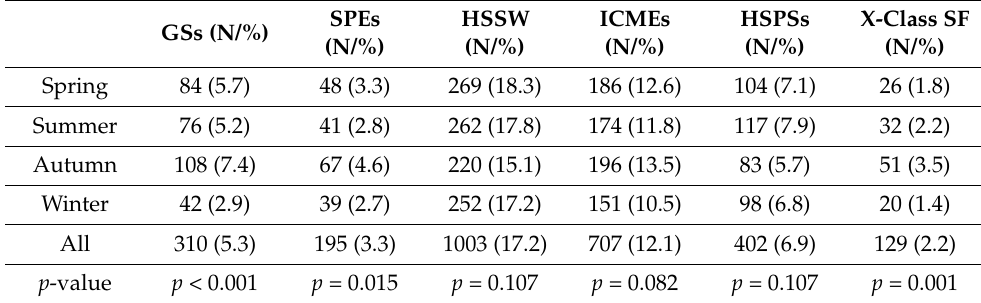
Table 3. Number and percentage of the days with space weather events by different seasons.